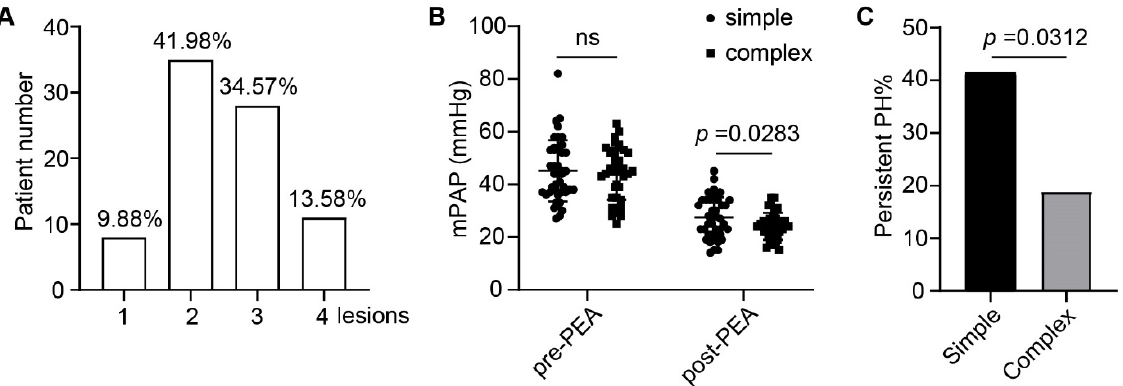
Figure 5. Correlation between lesion type and hemodynamic parameters of patients with CTEPH. ( A ) Number of CTEPH patients with one to four types of lesions. ( B ) mPAP before and after PEA procedure in patients with simple (one to two types) and complex (three to four types) lesions. ( C ) Percentage of persistent pulmonary hypertension (mPAP ≥ 30 mmHg) after PEA in patients with simple and complex lesions. Data are presented as the mean ± SD or percentage. Student’s t -test for ( B ) and chi-square test for ( C ).